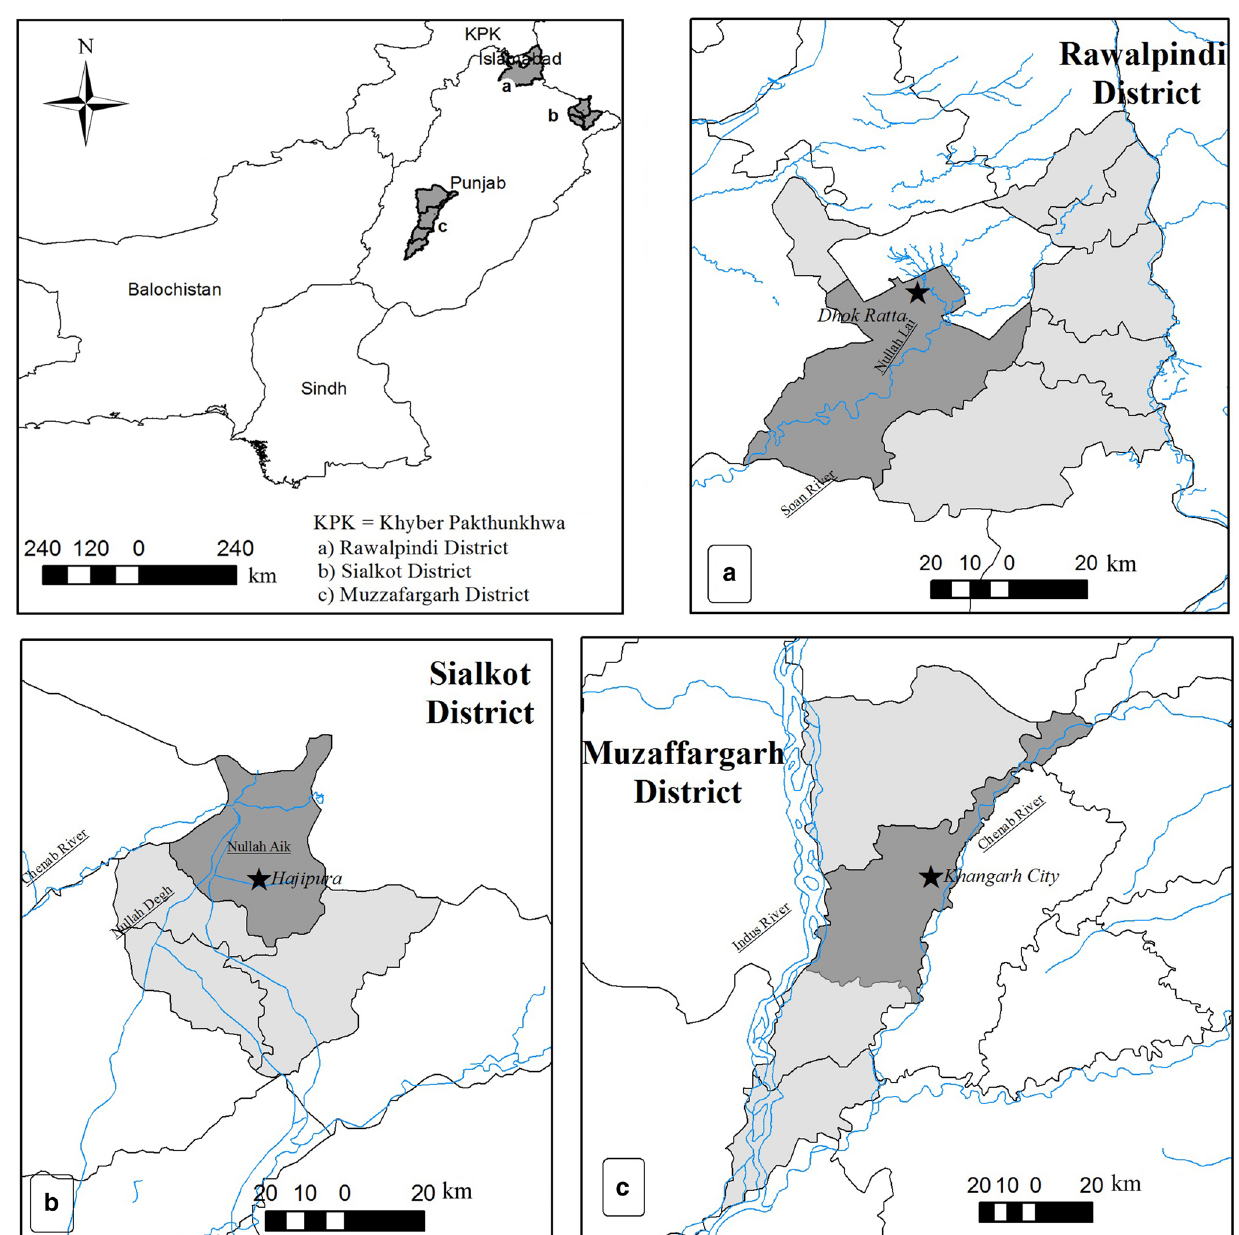
Fig. 1 Map of the study areas in Punjab Province, Pakistan, showing the location of the three selected study sites in a Rawalpindi, b Sialkot, and c Muzaffargarh